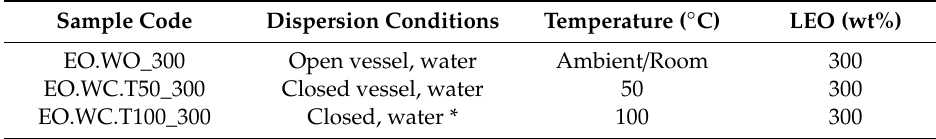
Table 4. Experimental tests performed with 300 wt% LEO, MMT and 10 wt% of CPB. Sample